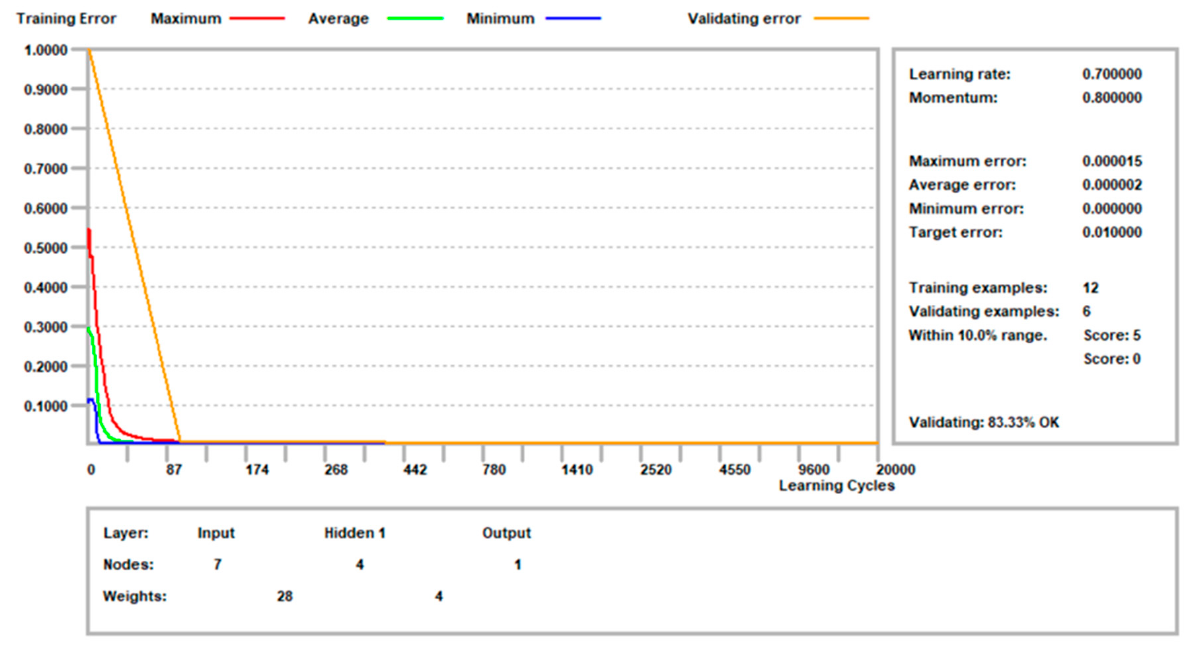
Figure 5. The ANN learning process.